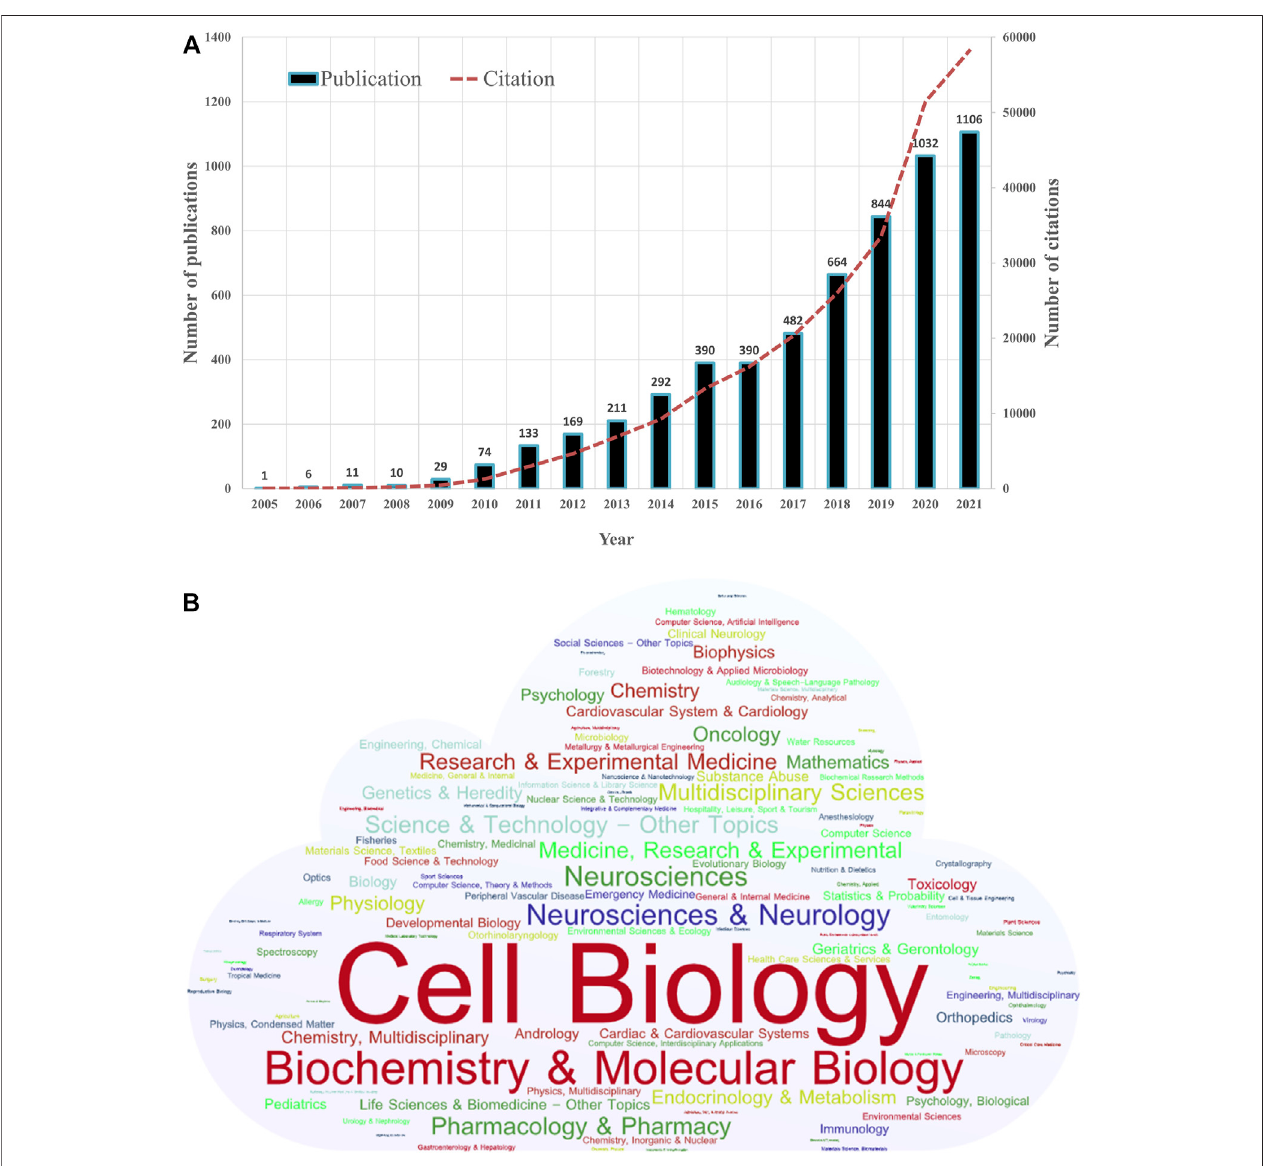
FIGURE 2 | Distribution of publications on mitophagy by year and category. (A) Number of annual publications and citations of mitophagy from 2005 to 2021 globally. (B) The word cloud map of the subject categories on mitophagy (Created with https://wordart.com/).